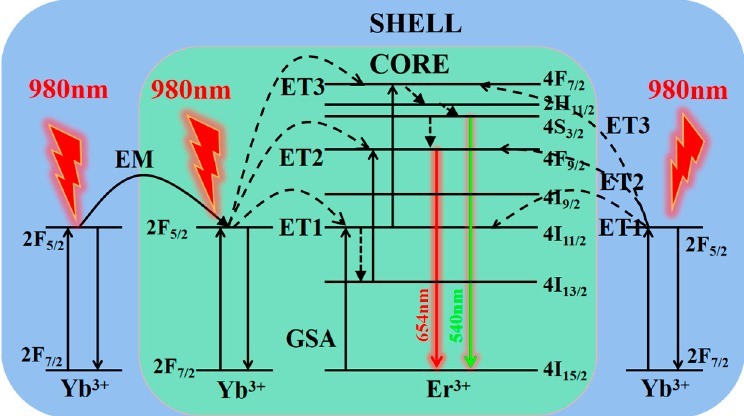
Figure 7. Energy level diagrams of Er 3+ and Yb 3+ ions as well as proposed UC mechanisms.